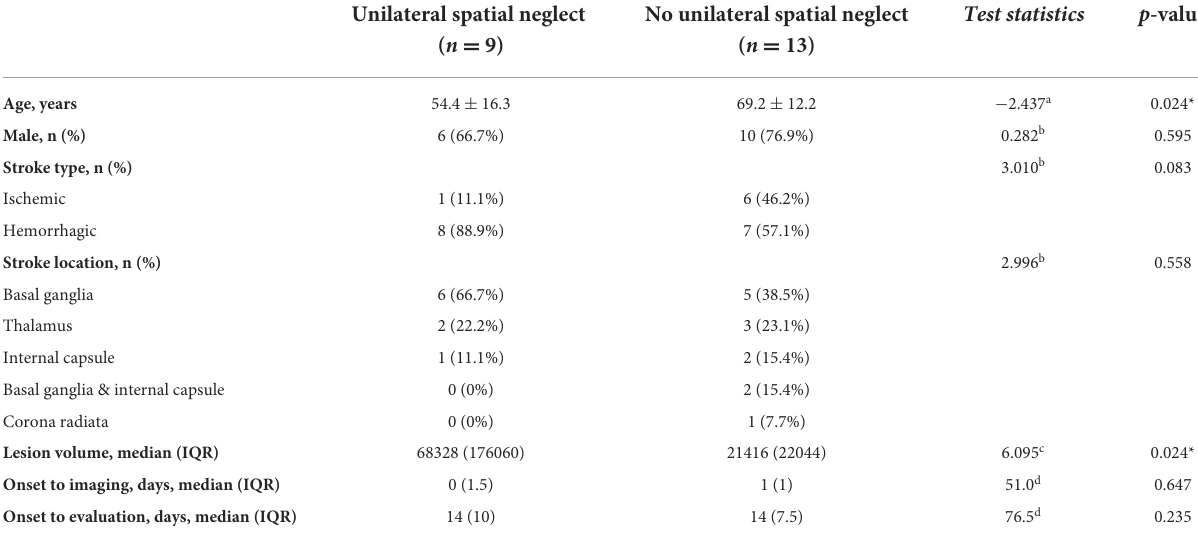
TABLE 1 Comparing the baseline